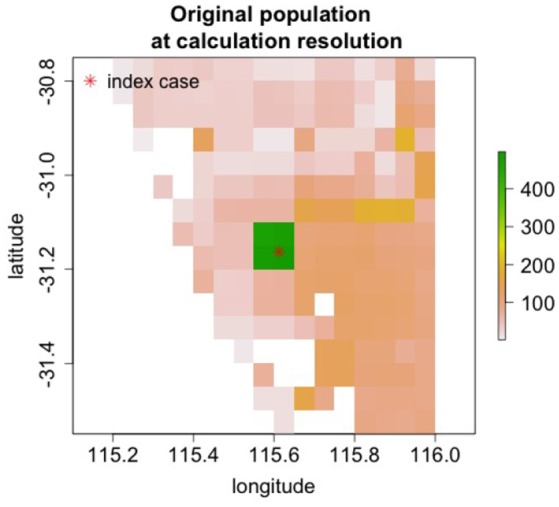
Starting population in Fremantle, Australia.